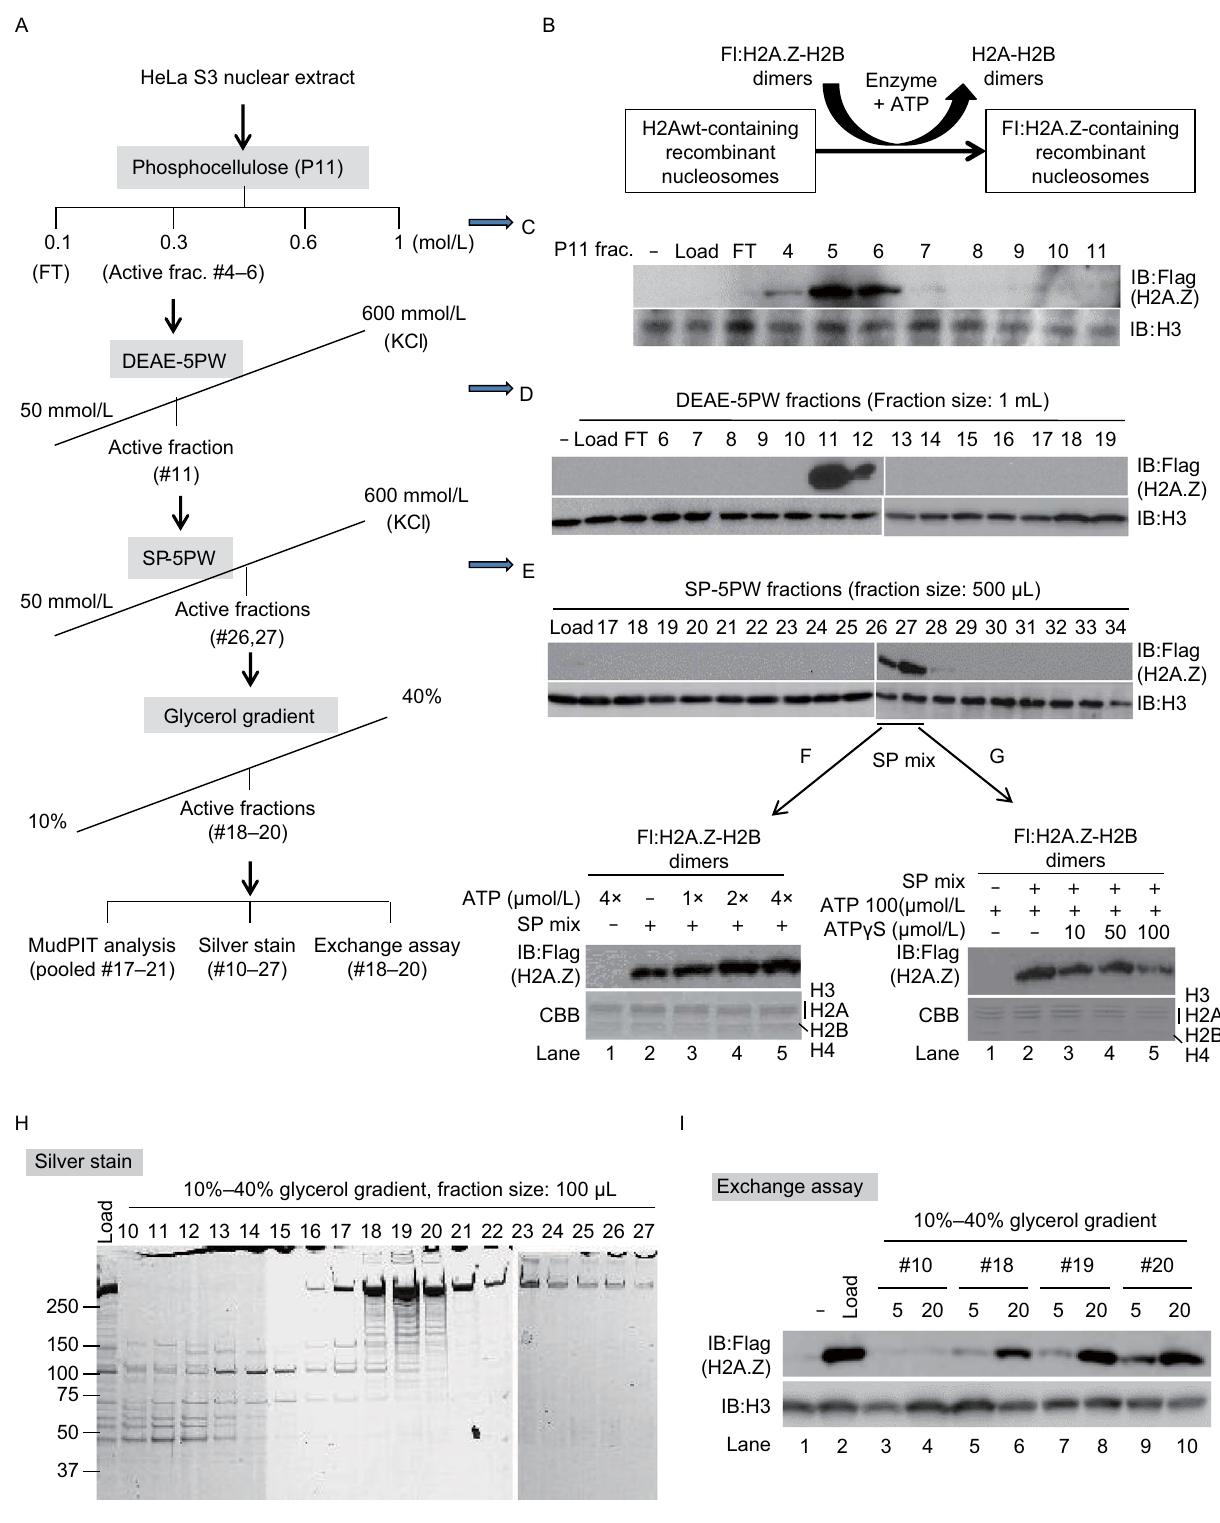
Figure 1. Fractions with H2A . Z-H2A replacement activity were puri fi ed by multiple chromatography puri fi cation steps. (A) Schema of puri fi cation steps. (B) Enzyme activity reaction diagram. (C – E) Tracking for components with H2A.Z-H2A replacement activity. (F – G) SP mix exhibited ATP-dependent enzyme activity. (H) Silver stained polypeptides of 10% – 40% glycerol